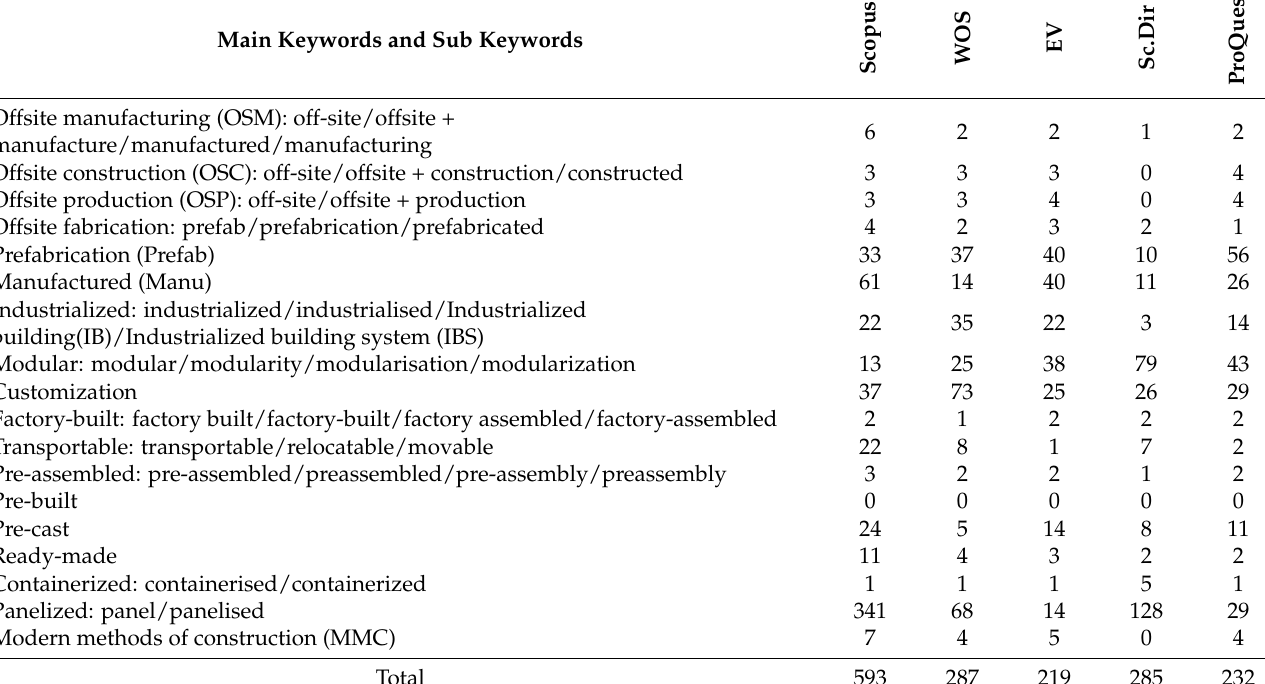
Table 1. Articles retrieved for review from different search engines.